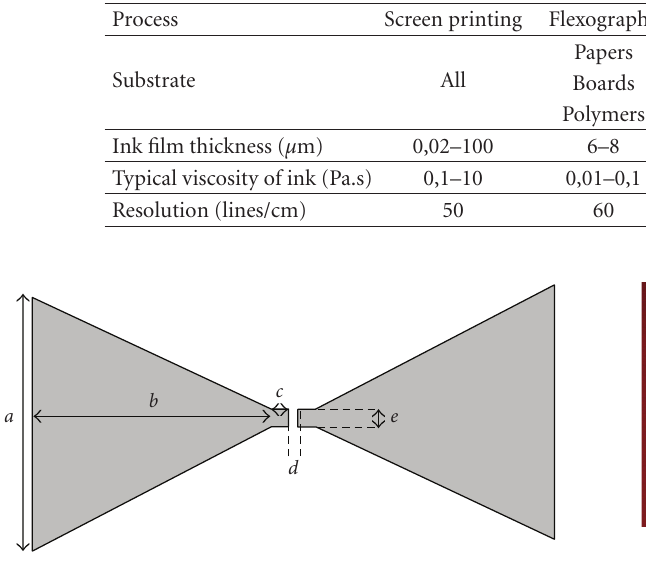
Figure 1: The geometry of the bow-tie antenna design. The dimen- sions are a = 43mm, b = 42 . 5 mm, c = 3 . 5mm, d = 2mm, and e = 3mm.